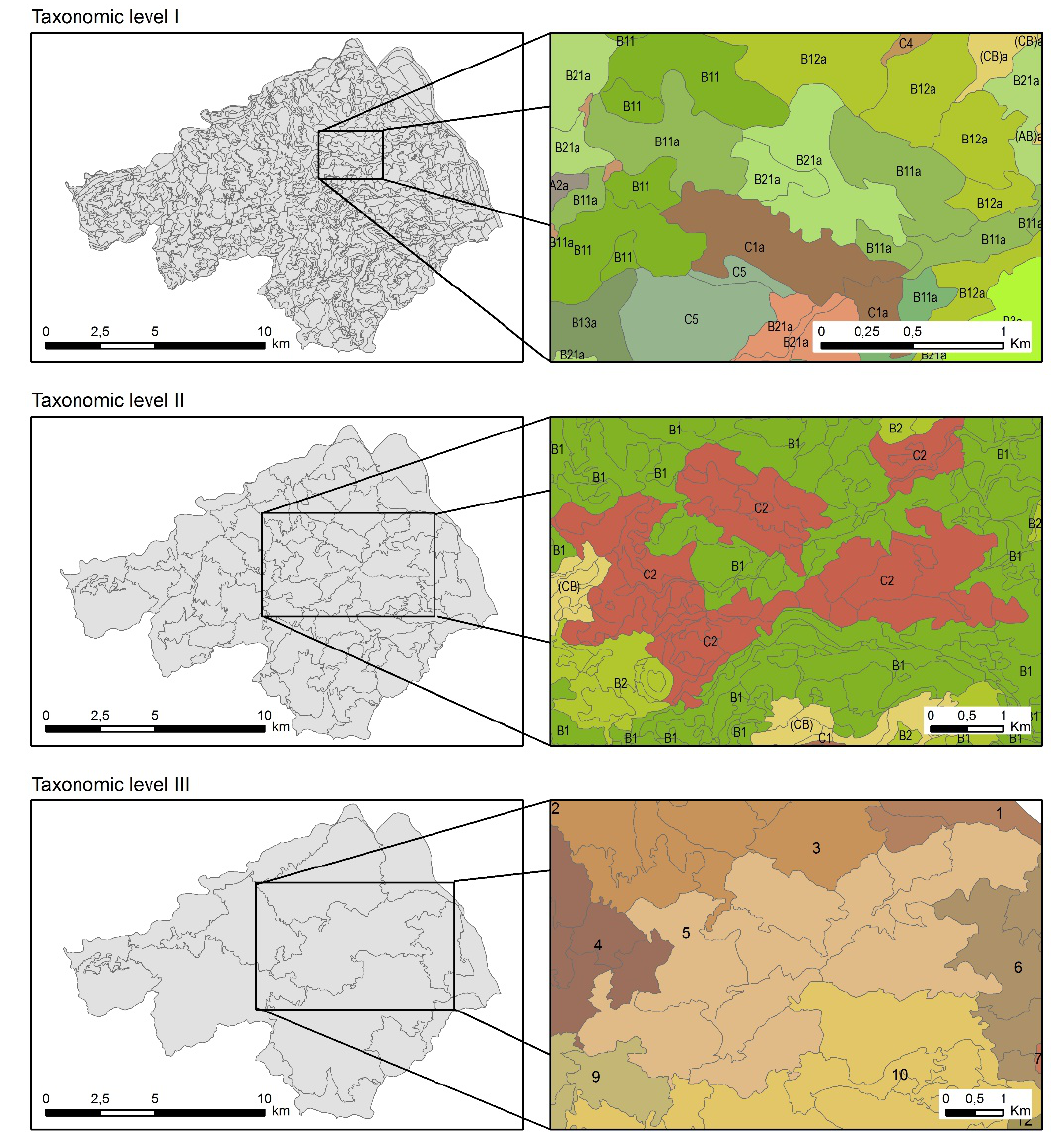
Figure 5: General overview and zoomed detail (roughly the same area at three levels) for each of the three taxonomic levels. Note that Level I delineations are also depicted at Level II, and Level II delineations at Level III.